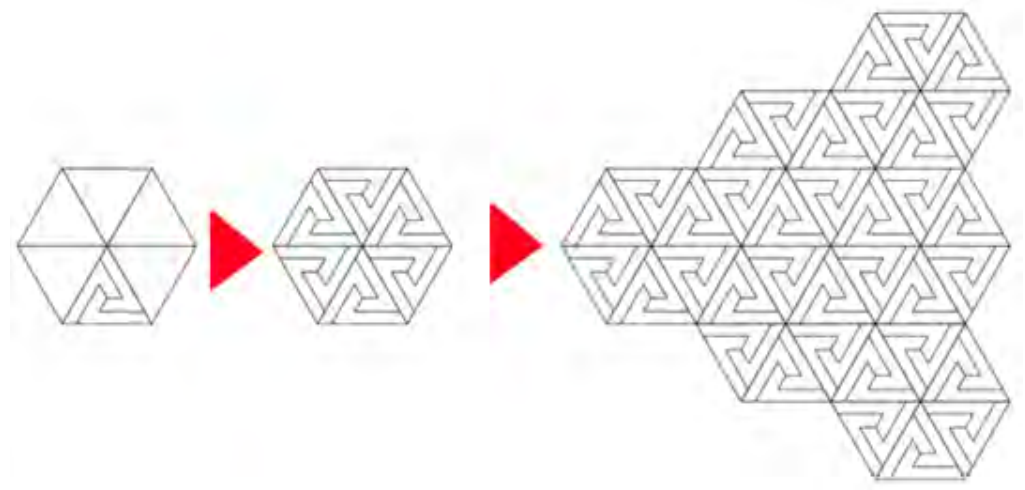
Figure 5. Mainsteps of geometric pattern